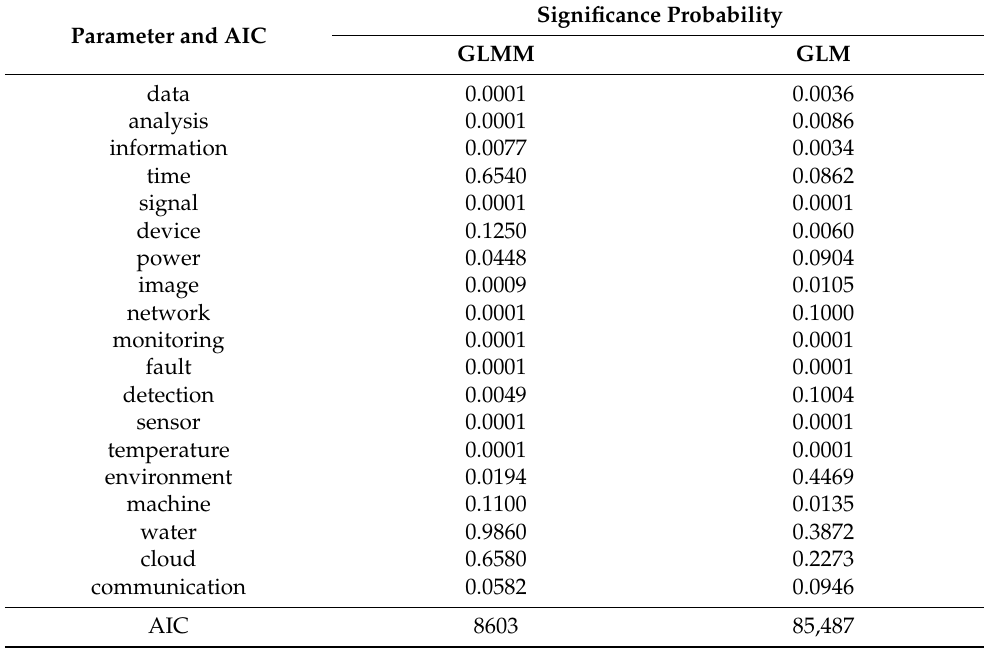
Table 4. Comparison of performance between GLMM and